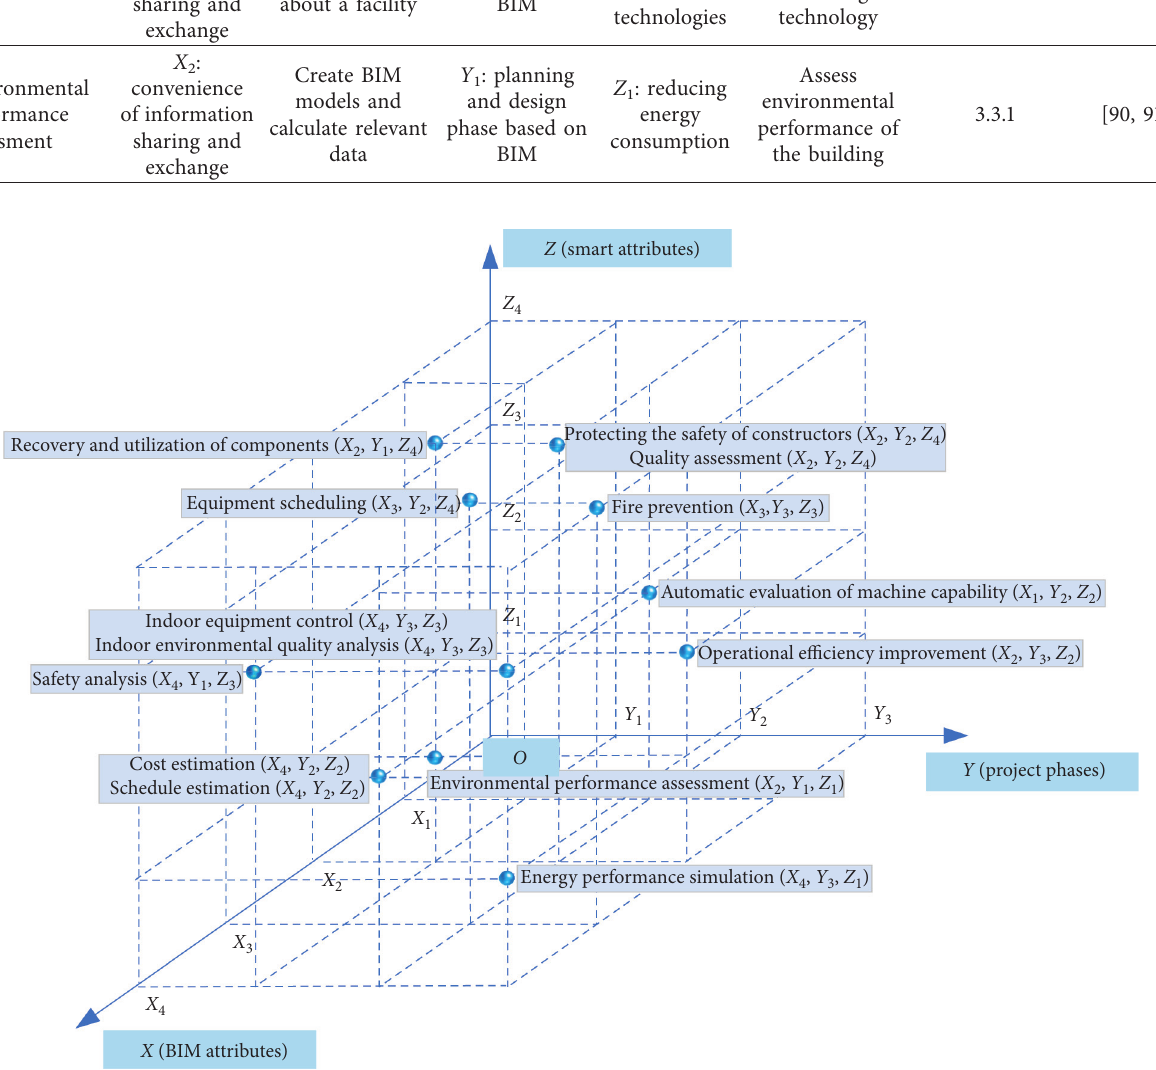
Figure 7: The cross-analysis of BIM attributes ( X ), project phases ( Y ), and smart attributes ( Z